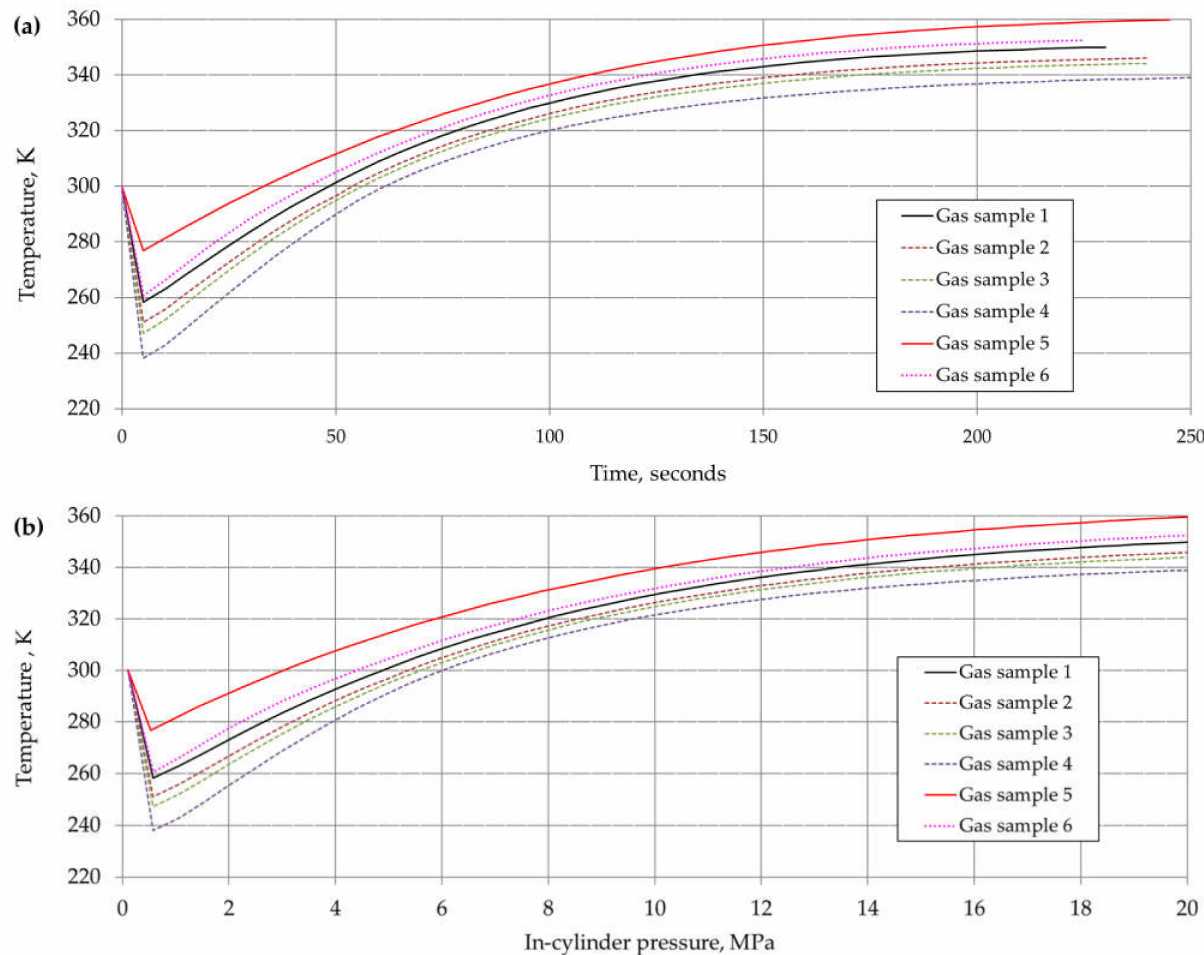
Figure 5. Temperature changes of the considered natural gas mixtures during the composite tank fast filling process: ( a ) vs. pressure change in the composite tank; ( b ) vs. filling time of the composite